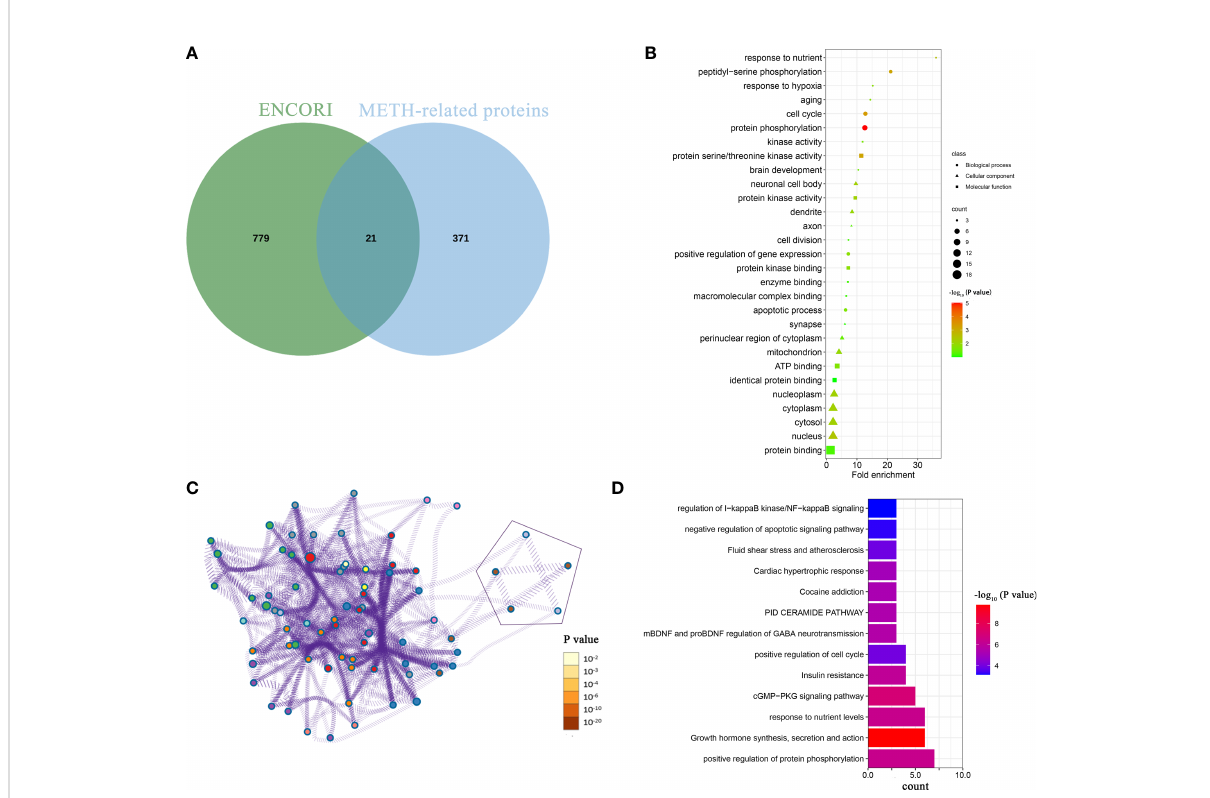
FIGURE 3 Bioinformatic analysis of downstream mechanism of miR-129-1-3p in METH-induced dopaminergic apoptosis. (A) Venn intersection of possible targets of miR-129-1-3p from ENCORI and METH-related proteins. (B) GO analysis of 21 proteins. This panel shows the top 10 enriched items for each of the biological process and molecular function and cellular component. Fold enrichment = (enriched gene counts/pop hits)/(list total gene counts/pop total hits). (C) pathway and process analysis of 21 proteins by Metascape. Each process or pathway was represented by a single dot. The line between the dots means that there is an overlap between the proteins enriched by the two processes or pathways. The 5 points representing apoptosis-related processes or pathways were enclosed by geometric fi gures. (D) Enriched pathways and processes of 21 proteins sorted by enriched gene counts from